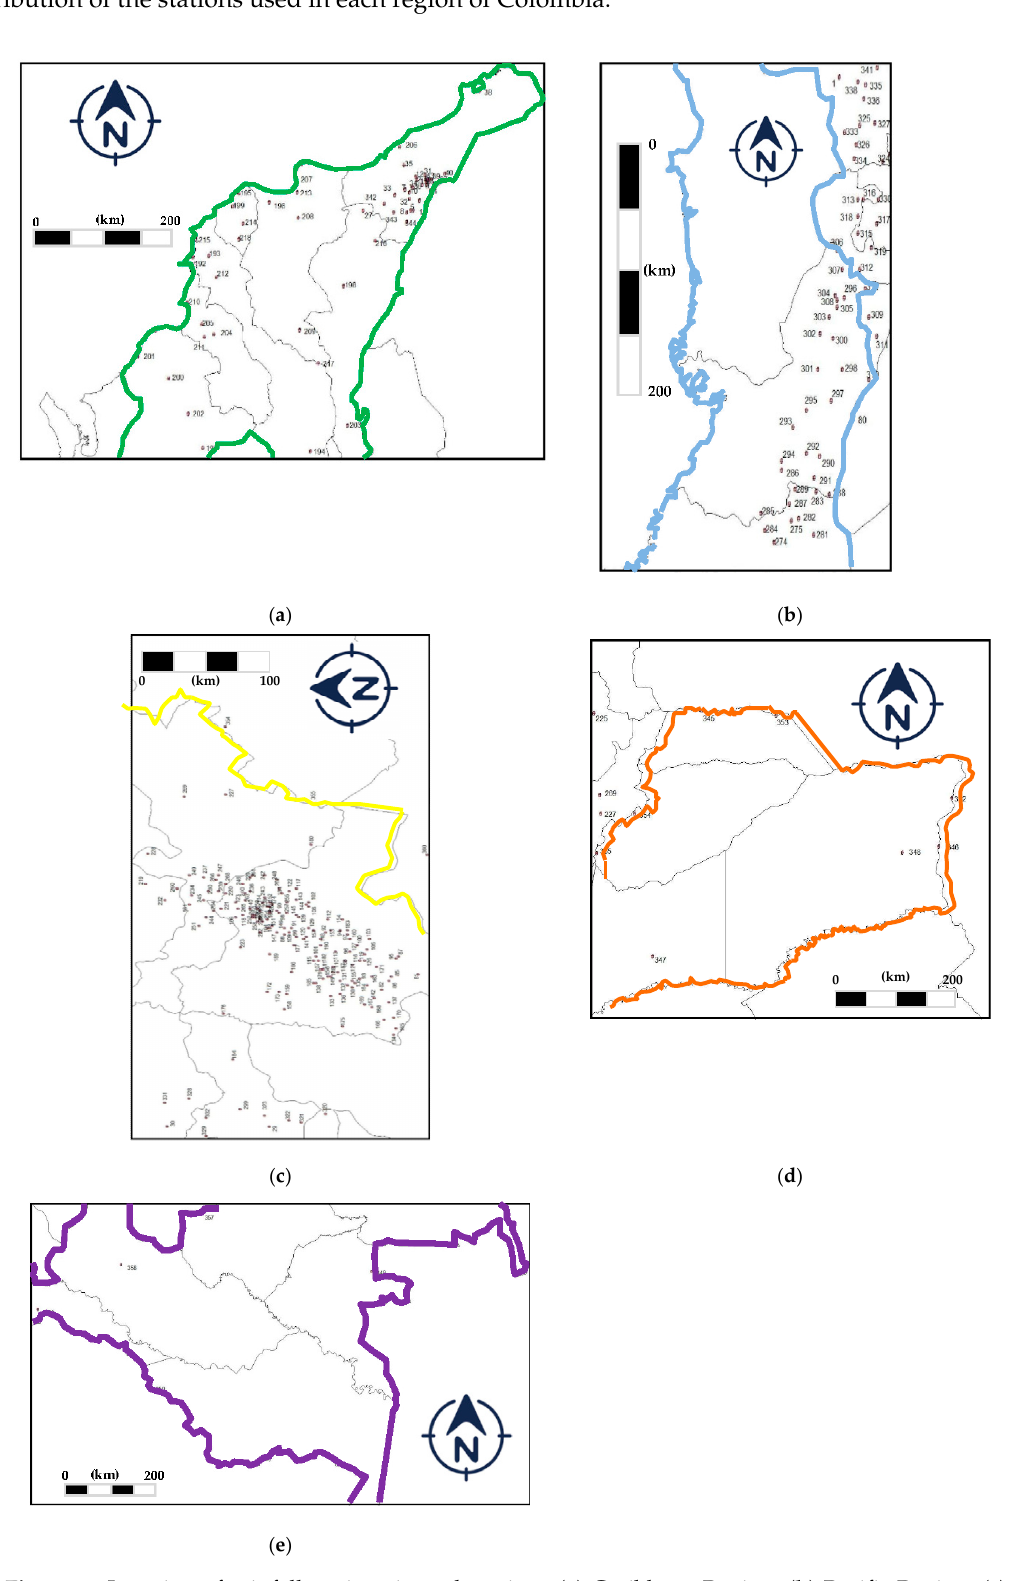
Figure 2. Location of rainfall stations in each region. ( a ) Caribbean Region; ( b ) Pacific Region; ( c ) Andean Region; ( d ) Orinoquía Region; ( e ) Amazonas Region.